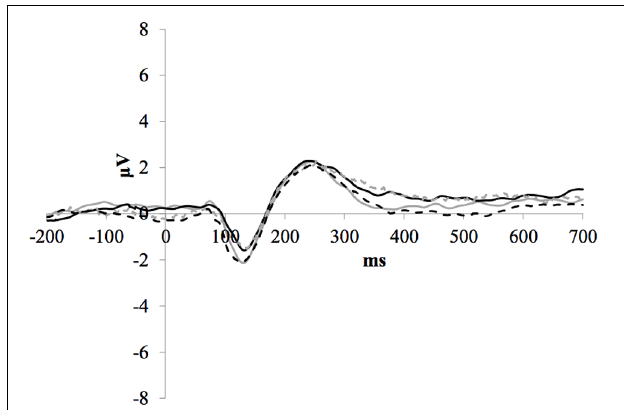
FIGURE 3 | Grand average ERP waveforms of the frequent stimuli for the trained (solid line) and control (dotted line) groups at baseline (gray) and post-test (black) at electrode